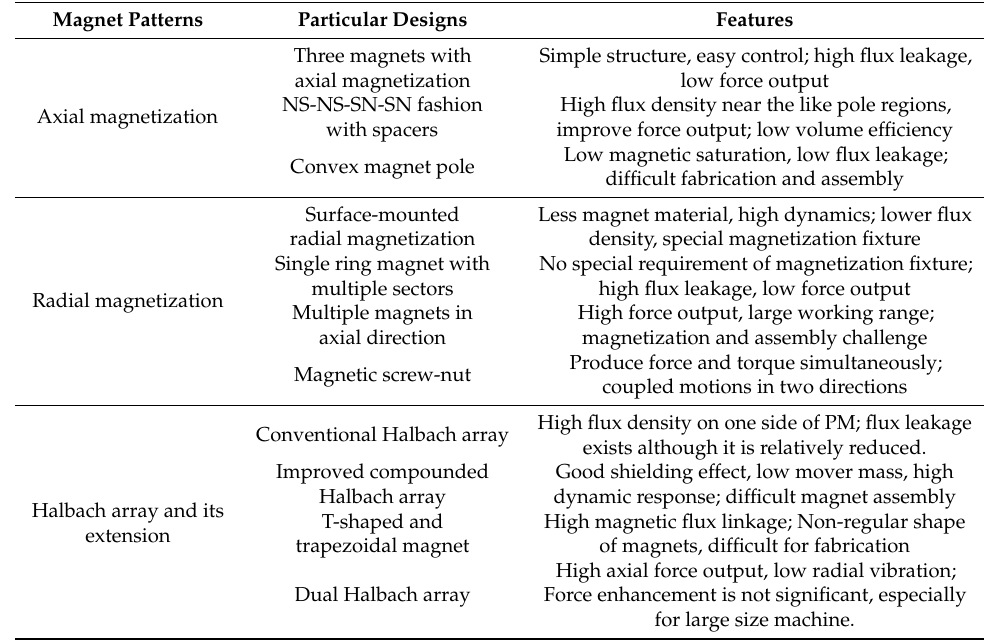
Table 1. Comparison of magnetization patterns of linear machines.